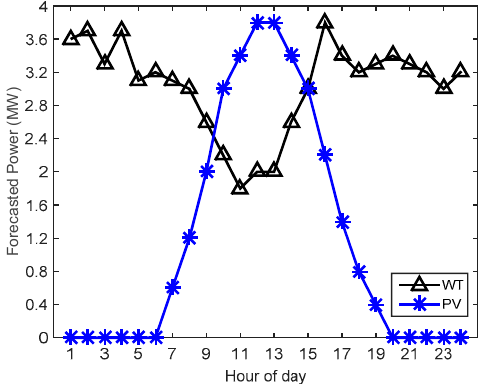
Figure 4. Forecasted power output of WTs and PVs. Table 2. DERs’ maintenance